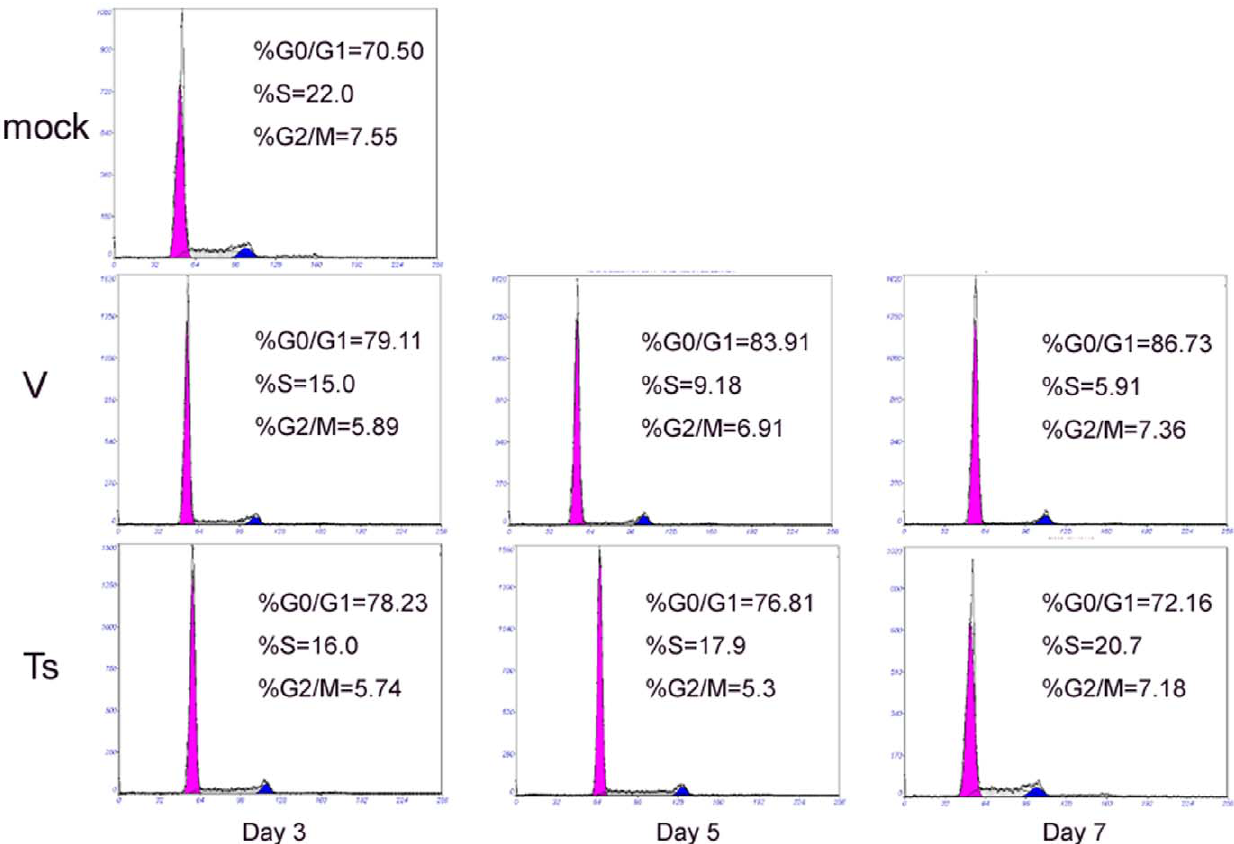
Figure 4. The depletion of B220 + B cells in BM is associated with arrested cell cycle. Following infection, BM cells from day 1, 3, 5, 7 post- infection were prepared and stained with PE-Cy5-anti-FITC and PI and analyzed by flow cytometer. The results were analyzed using MultiCycle AV software. Each graph is from an individual mouse, but is representative of three mice per group and three independent experiments.